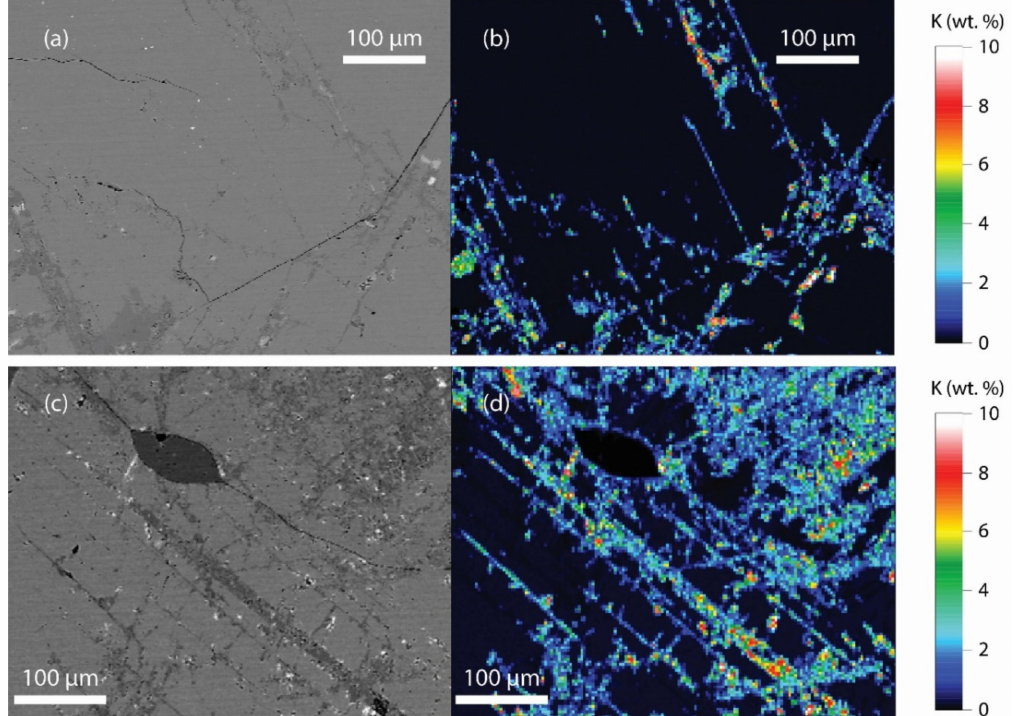
Figure 5. ( a ) Back-scattered electron (BSE) image of a feldspar grain, sample 6KB52; ( b ) quantitative K (wt.%) distribution map of the same grain, obtained by EPMA; ( c ) BSE image of a feldspar and quartz grain (darker grain) in sample 6KB50; ( d ) quantitative K (wt.%) distribution map of the same